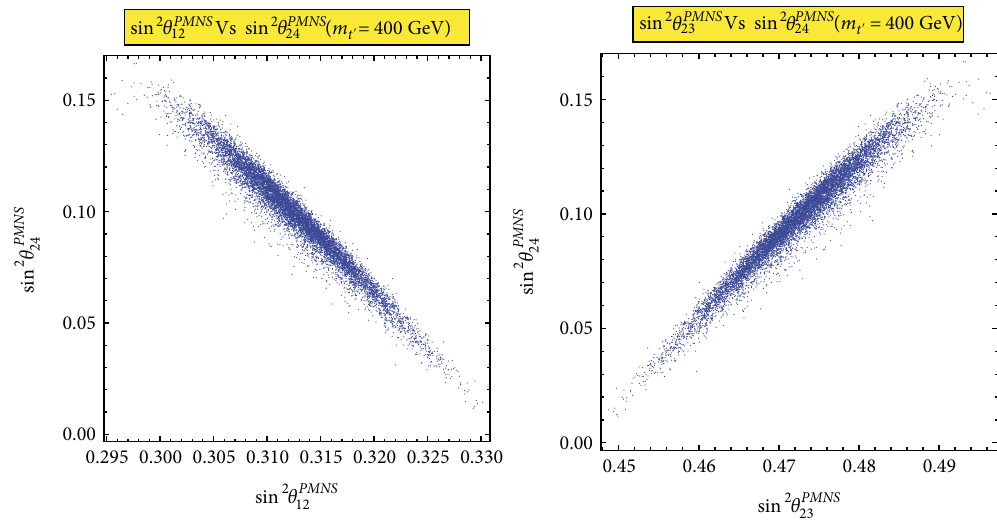
Figure 1: Correlation plot for sin 2 𝜃 𝑃𝑀𝑁𝑆